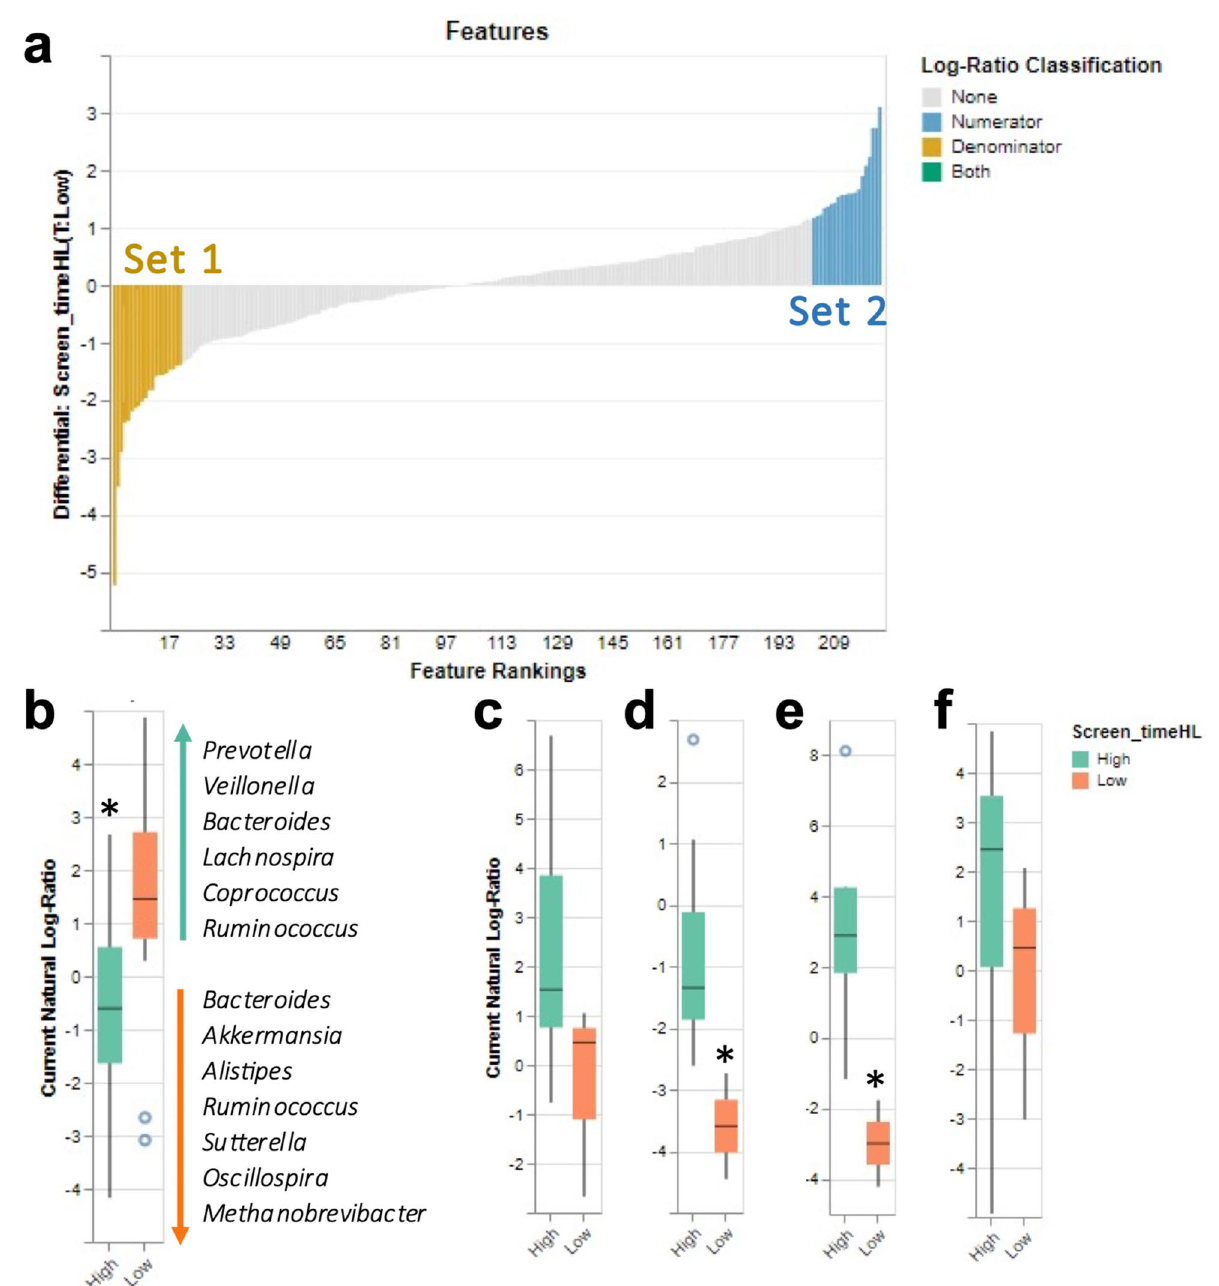
Figure 4. Differential analysis of log ratio classification. ( a ) Comparison of log ratio of the 20 highest and 20 lowest ranked ASVs associated with screen time classification. ( b ) High screen time classification had a significantly greater log ratio of set 2 compared to set 1 ( t -test); ( c ) Prevotella//Runimococcaceae (Mann– Whitney U test); ( d ) Peptostreptococcaceae/Runimococcaceae (Mann–Whitney U test); ( e ) Bacteroides/ Akkermansia (Mann–Whitney U test); ( f ) Prevotella/Bacteroides (Mann–Whitney U test). * p <